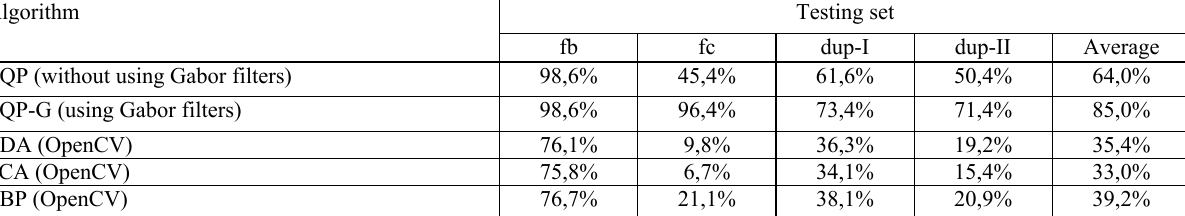
Table 2. The experimental results on FERET